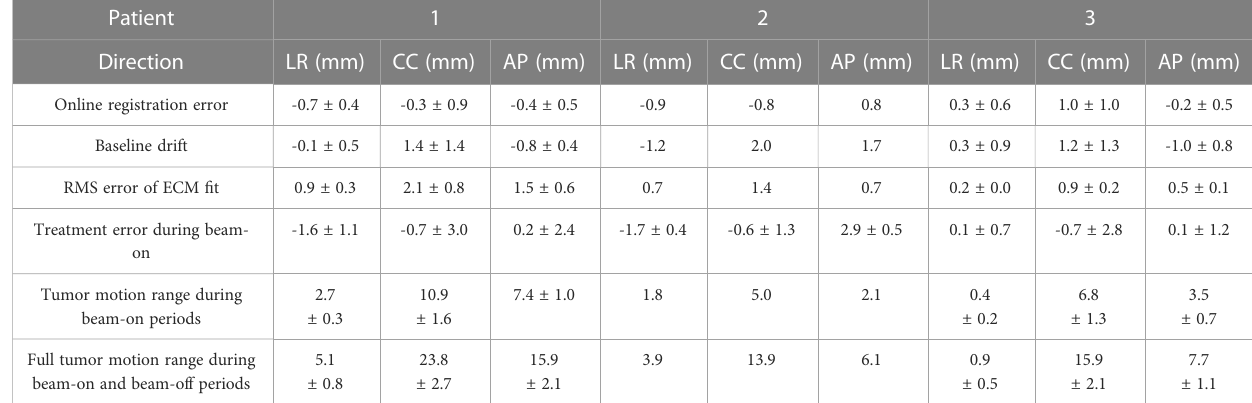
TABLE 1 Mean ± standard deviation over all fractions of the online registration error, baseline drift, root-mean-square (RMS) ECM fi tting error, tumor position error during spot delivery (treatment error), and the tumor motion range (2 nd to 98 th percentile motion) during beam-on and during fi eld delivery regardless of beam-on